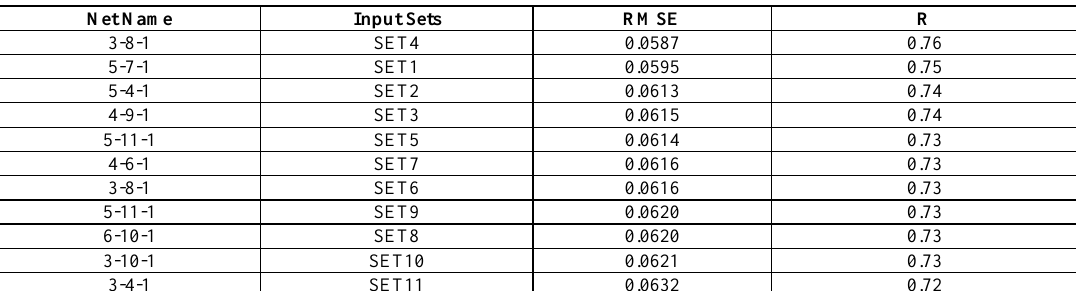
Table 3. Comparison of ANN input sets